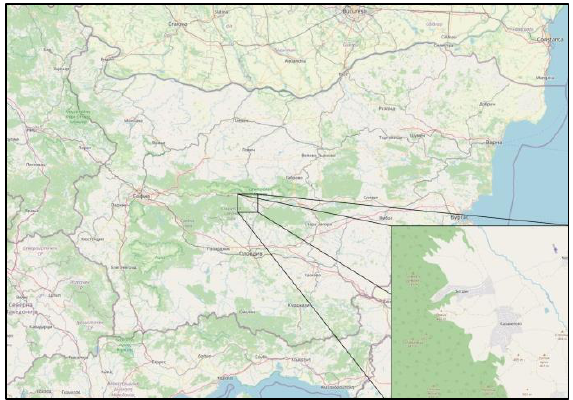
Figure 1 . Location of case study: Bogdan and Karavelovo, Karlovo municipality,